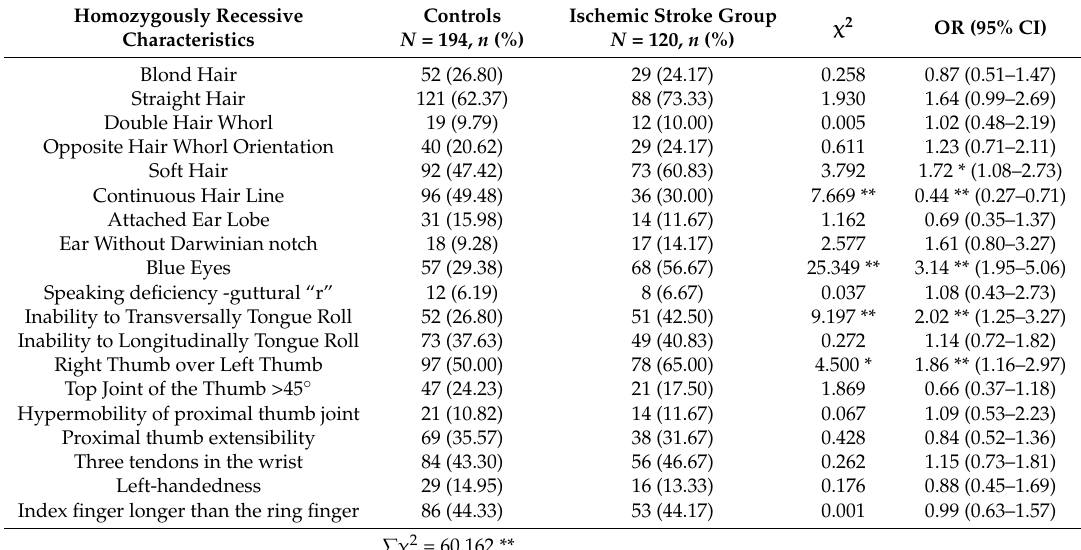
Table 2. Frequencies of homozygously recessive characteristics among patients with manifested ischemic stroke and